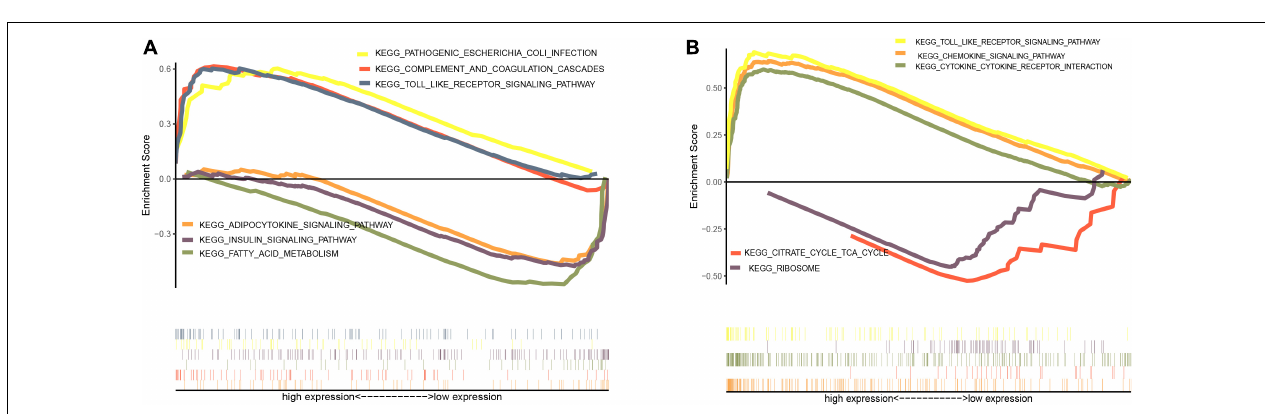
FIGURE 2 | The difference of 22 kinds of immune cells in obesity and non-obesity, blue represents obese adipose tissue, red represents non-obesity adipose tissue.